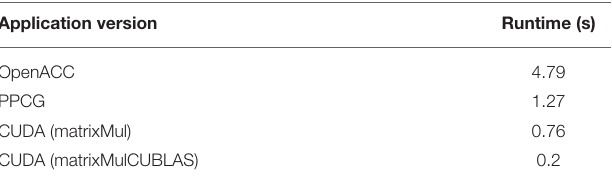
TABLE 4 | Runtimes of automatically transformed code vs. manually optimized code for the matrix multiplication of two 4096 square matrices.